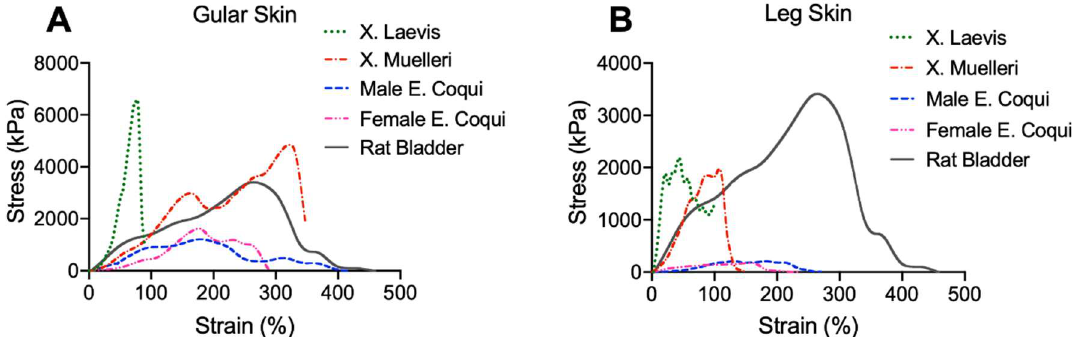
Figure 2. Representative uniaxial stress–strain curves of ( a ) gular skin tissue and ( b ) leg skin of different anuran species and their comparison to the rat bladder.